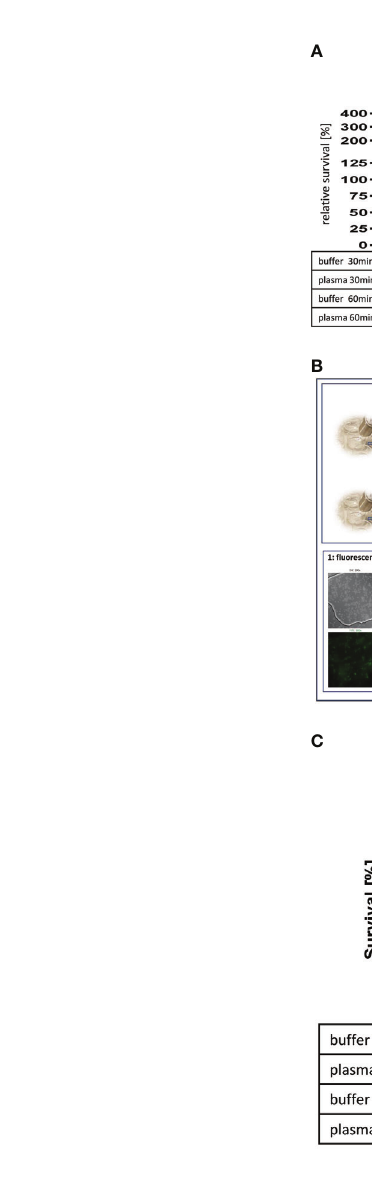
FIGURE 3 | (A) Survival of the streptococcal strains AP1, AP4, AP12, MC25, E. coli K12 and S. pneumoniae F23 following incubation with buffer or plasma. The bacterial strains were grown to exponential phase and incubated in 5% human plasma and assay buffer for 30min. Bacteria were then washed and incubated for another 30min or 60min. The graph represents the relative survival rate, calculated based on the platings for the 30min and 60min time points divided through the starting CFU before the plasma and buffer incubation. Except for K12. Instead of the starting CFU after the plasma incubation, the CFU after buffer incubation was chosen. This was done since the buffer CFU differs from 112.6x10 4 after buffer incubation to 2.6x10 4 after plasma incubation and would mislead to a high positive survival rate by increasing to 5.7 x10 4 at 30min. CFU counts were measured from 10 -4 dilutions on THY agar plates. Assays were performed as technical quadruplicates with biological triplicates. Signi fi cance bars: To compare buffer and plasma sample values at the same time point a one-way ANOVA (Tukey ’ s multiple comparisons test) was used. *p ≤ 0.05, ***p ≤ 0.001, ns p=not signi fi cant. (B) Work fl ow with in vitro fi brin clot assay. Upper left starting with resuspending the buffer and plasma incubated bacteria in normal or CAP-treated buffer. Afterwards clot assay was started by mixing bacterial solution as well as fi brinogen and thrombin on the collagen coated coverslip. Initial fi brin network formation was enabled for 5min before bacterial clot was fl oated with buffer including components to test. 30min and 60min time points were further processed and either used for LIVE/DEAD ™ BacLight ™ staining or processed for correlative light-electron microscopy (CLEM). For the CLEM only scanning electron microscopy (SEM) was used to visualize fi brin network formation. (C) LL-37 and CTH induced bacterial killing inside a fi brin clot. S. pyogenes AP1 bacteria were grown to the exponential phase, incubated with 5% human plasma (grey dots) or buffer (black dots), and then embedded in a fi brin network. After a 30min and 60min incubation time bacterial survival was measured inside the clot. For buffer/plasma without N=18; plasma 30min CTH N=55; buffer 30min CTH N=49; plasma 60min CTH N=42; buffer 60min CTH, buffer 30min LL-37, buffer 60min LL-37, plasma 60min LL-37 all N= 40; plasma 30min LL-37 N=59 and for buffer 30min LL-37 N=60. The graphs display meanand standard error. Statistic tests performed on Prism (8.3.0) using a Mann-Whitney test. *p ≤ 0.05, ***p ≤